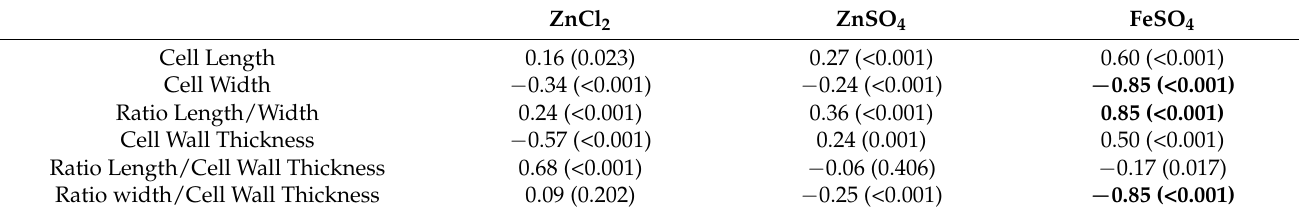
Table 3. Spearman correlation between morphometric parameters and maximum no-effect concentrations, shown as ρ ( p ). Strong ( ρ ≥ 0.8) and highly significant ( p < 0.01) correlations are highlighted (bold). n = 200 cells. ZnCl 2 ZnSO 4 FeSO 4 Cell Length 0.16 (0.023) 0.27 (<0.001) 0.60 (<0.001) Cell Width − 0.34 (<0.001) − 0.24 (<0.001) − 0.85 (<0.001) Ratio Length/Width 0.24 (<0.001) 0.36 (<0.001) 0.85 (<0.001) Cell Wall Thickness − 0.57 (<0.001) 0.24 (0.001) 0.50 (<0.001) Ratio Length/Cell Wall Thickness 0.68 (<0.001) − 0.06 (0.406) − 0.17 (0.017) Ratio width/Cell Wall